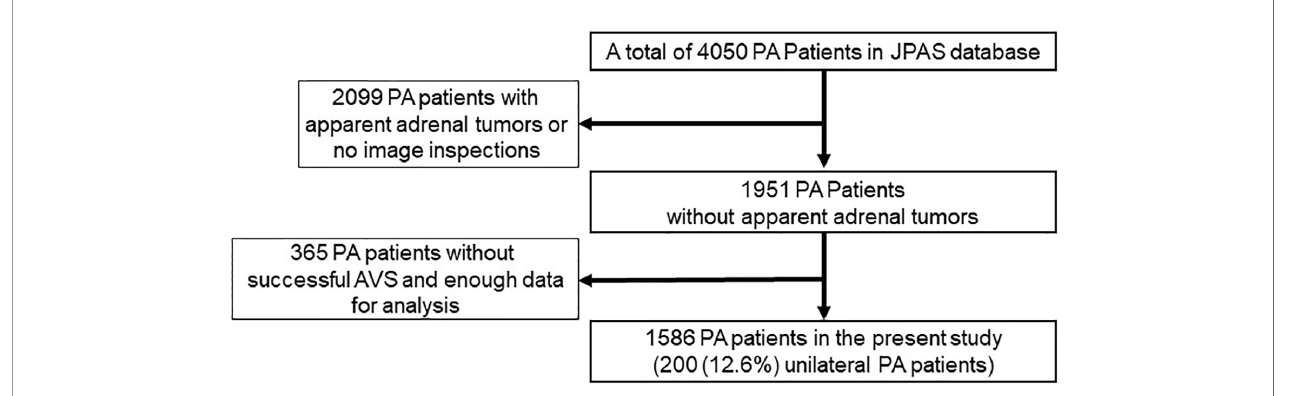
FIGURE 1 | Patient selection criteria for inclusion in this study.